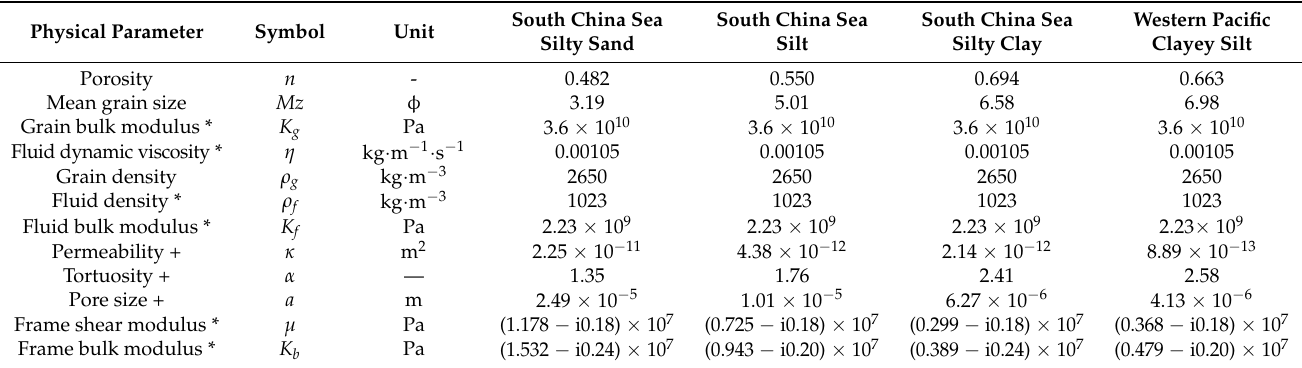
Table 2. The values of Biot–Stoll model input parameters for different sediment types.